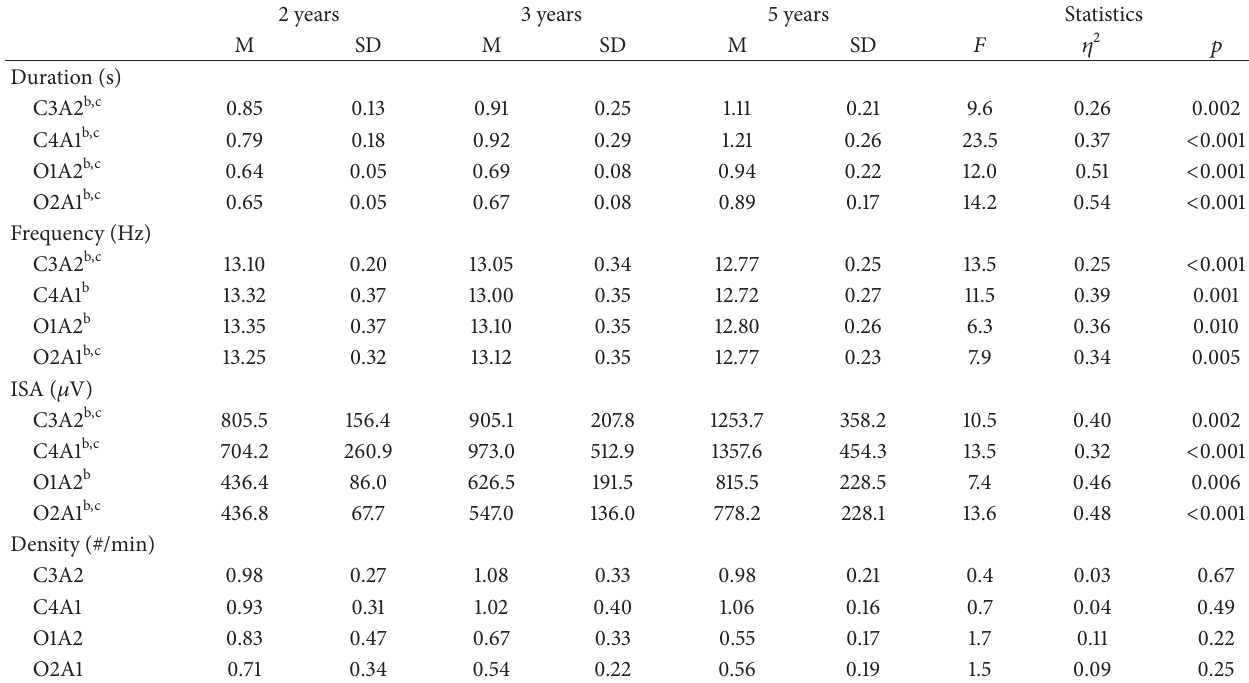
Table 2: Descriptive statistics (M, SD) of sleep spindle measures at ages 2, 3, and 5 years for each derivation (C3A2, C4A1, O1A2, and O2A1). Significant post hoc paired 𝑡 -tests (2-tailed) are denoted as a (2 years versus 3 years), b (2 years versus 5 years), and c (3 years versus 5